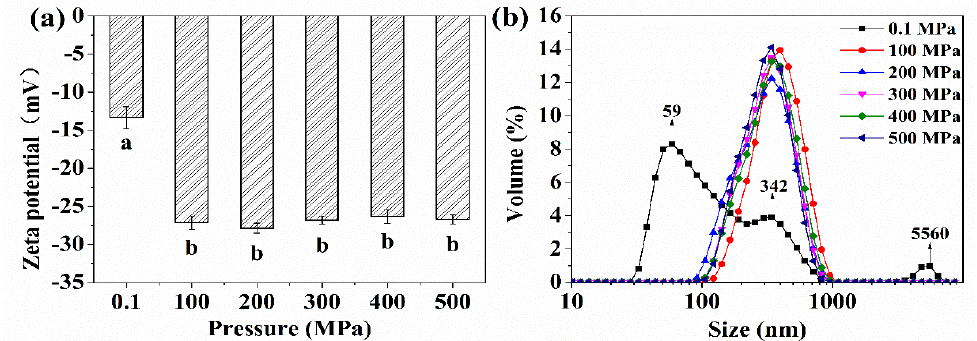
Figure 1. The zeta potential ( a ) and size distribution ( b ) of control and HP treated oyster proteins. Di ff erent lowercase letters indicate significant di ff erence between groups ( p <